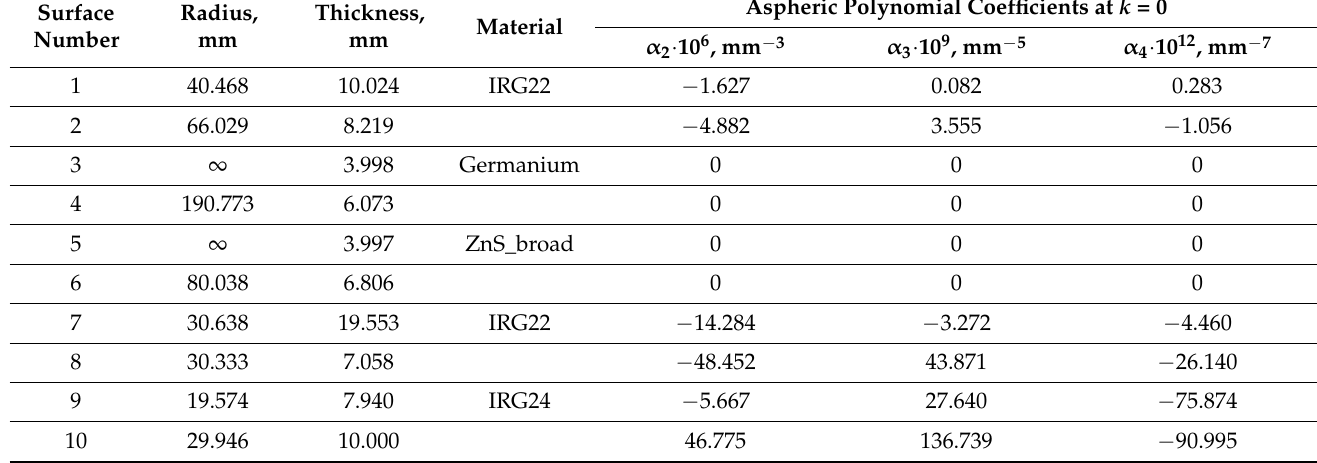
Table 2. Design parameters of the refractive version of the ultra-high-aperture athermal dual-range IR objective.